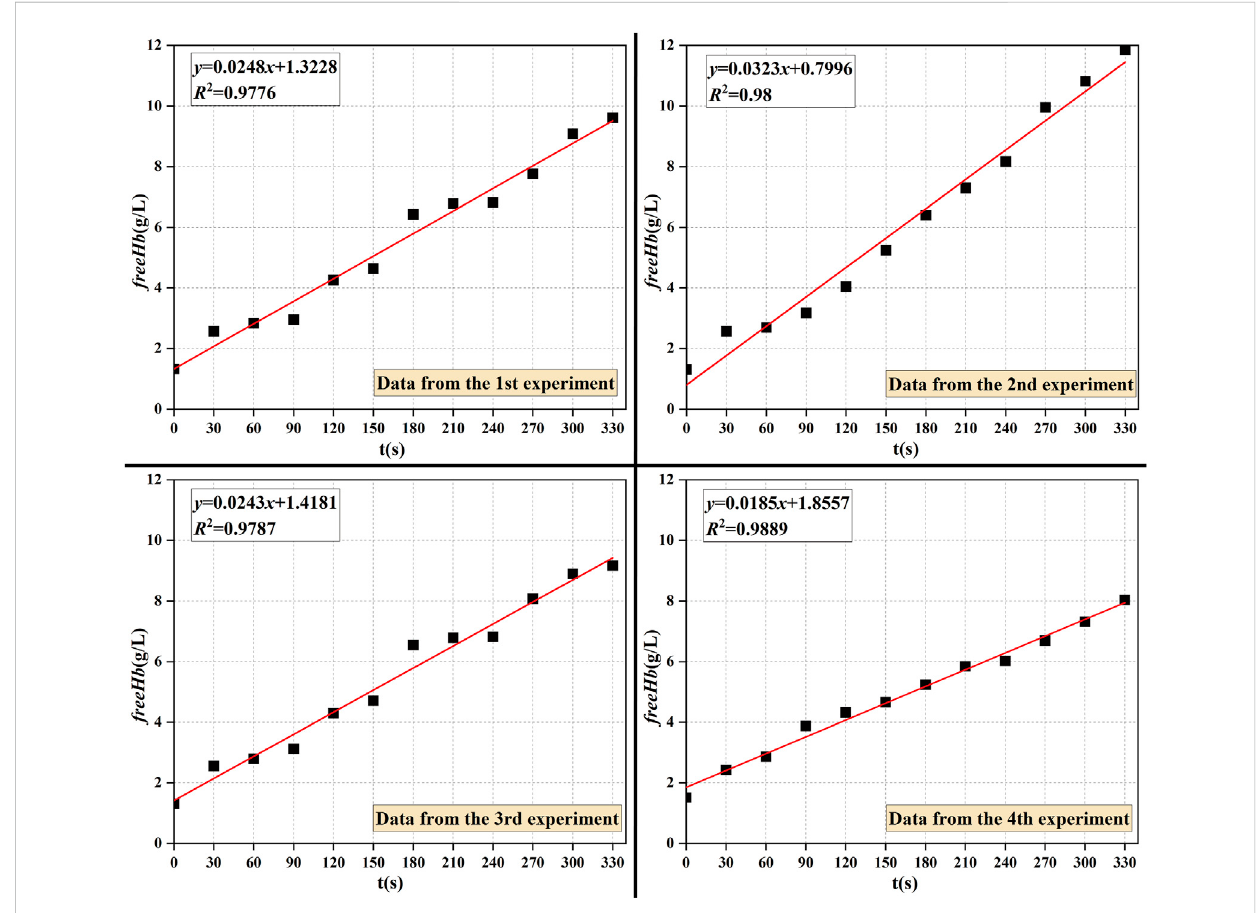
FIGURE 11 Experimentally measured plasma-free protein concentration over time.